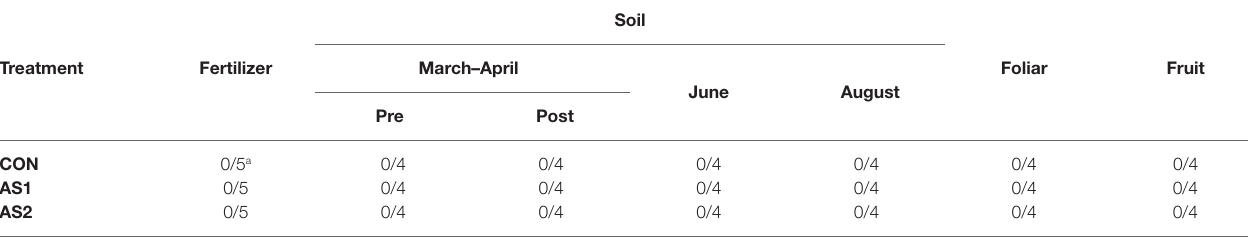
TABLE 6 | Listeria monocytogenes analyses in fertilizer, soil, foliar, and blueberry fruit samples in 2017–2018.